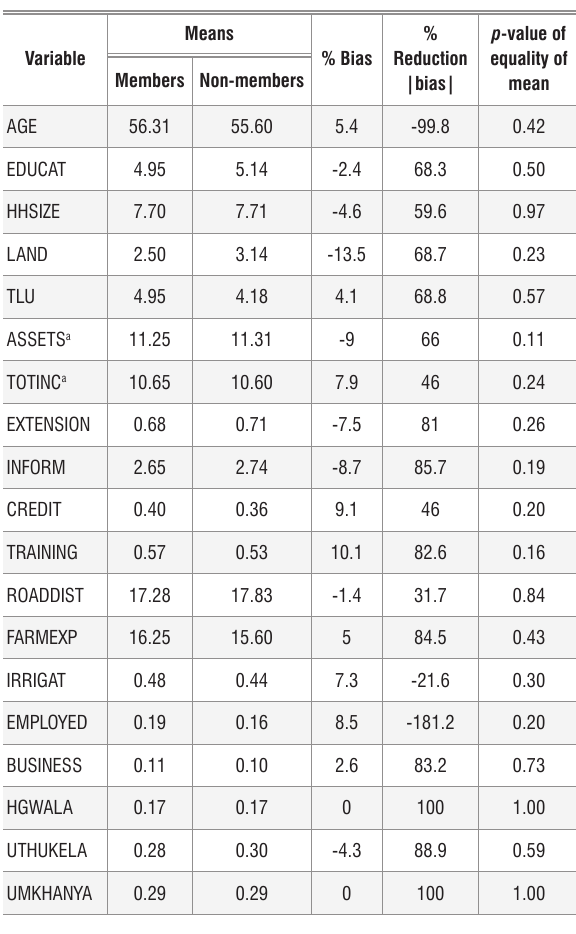
Impact of farmer group membership on inorganic fertiliser use level